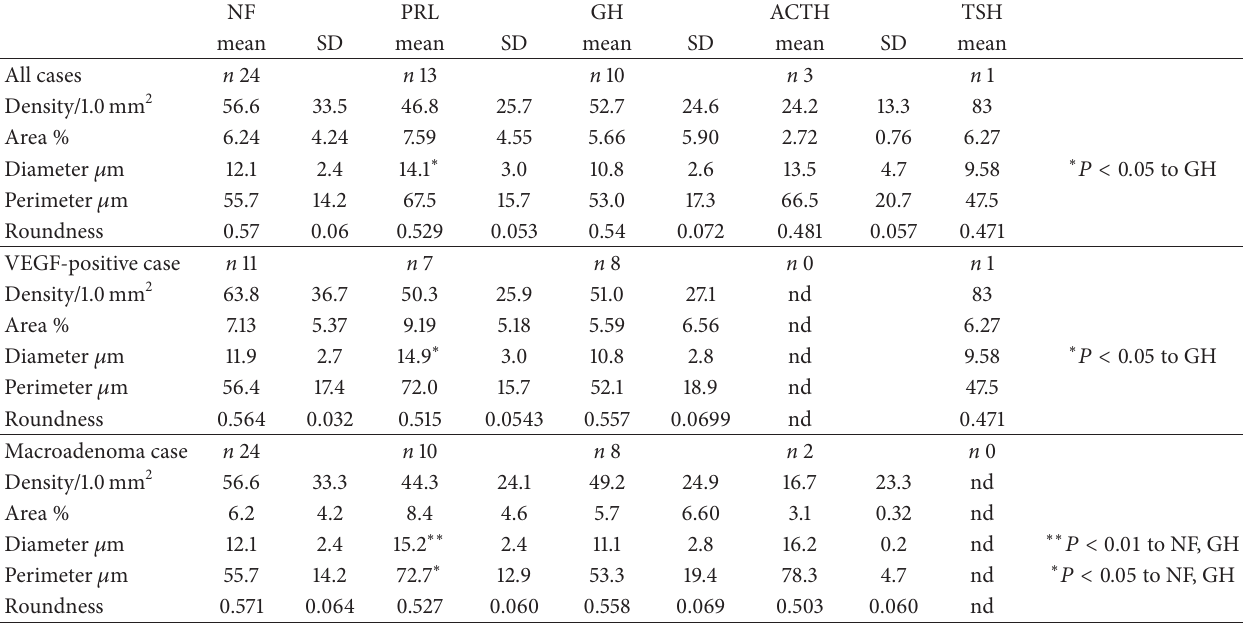
Table 3: Morphometric analysis of vascular architecture between adenoma